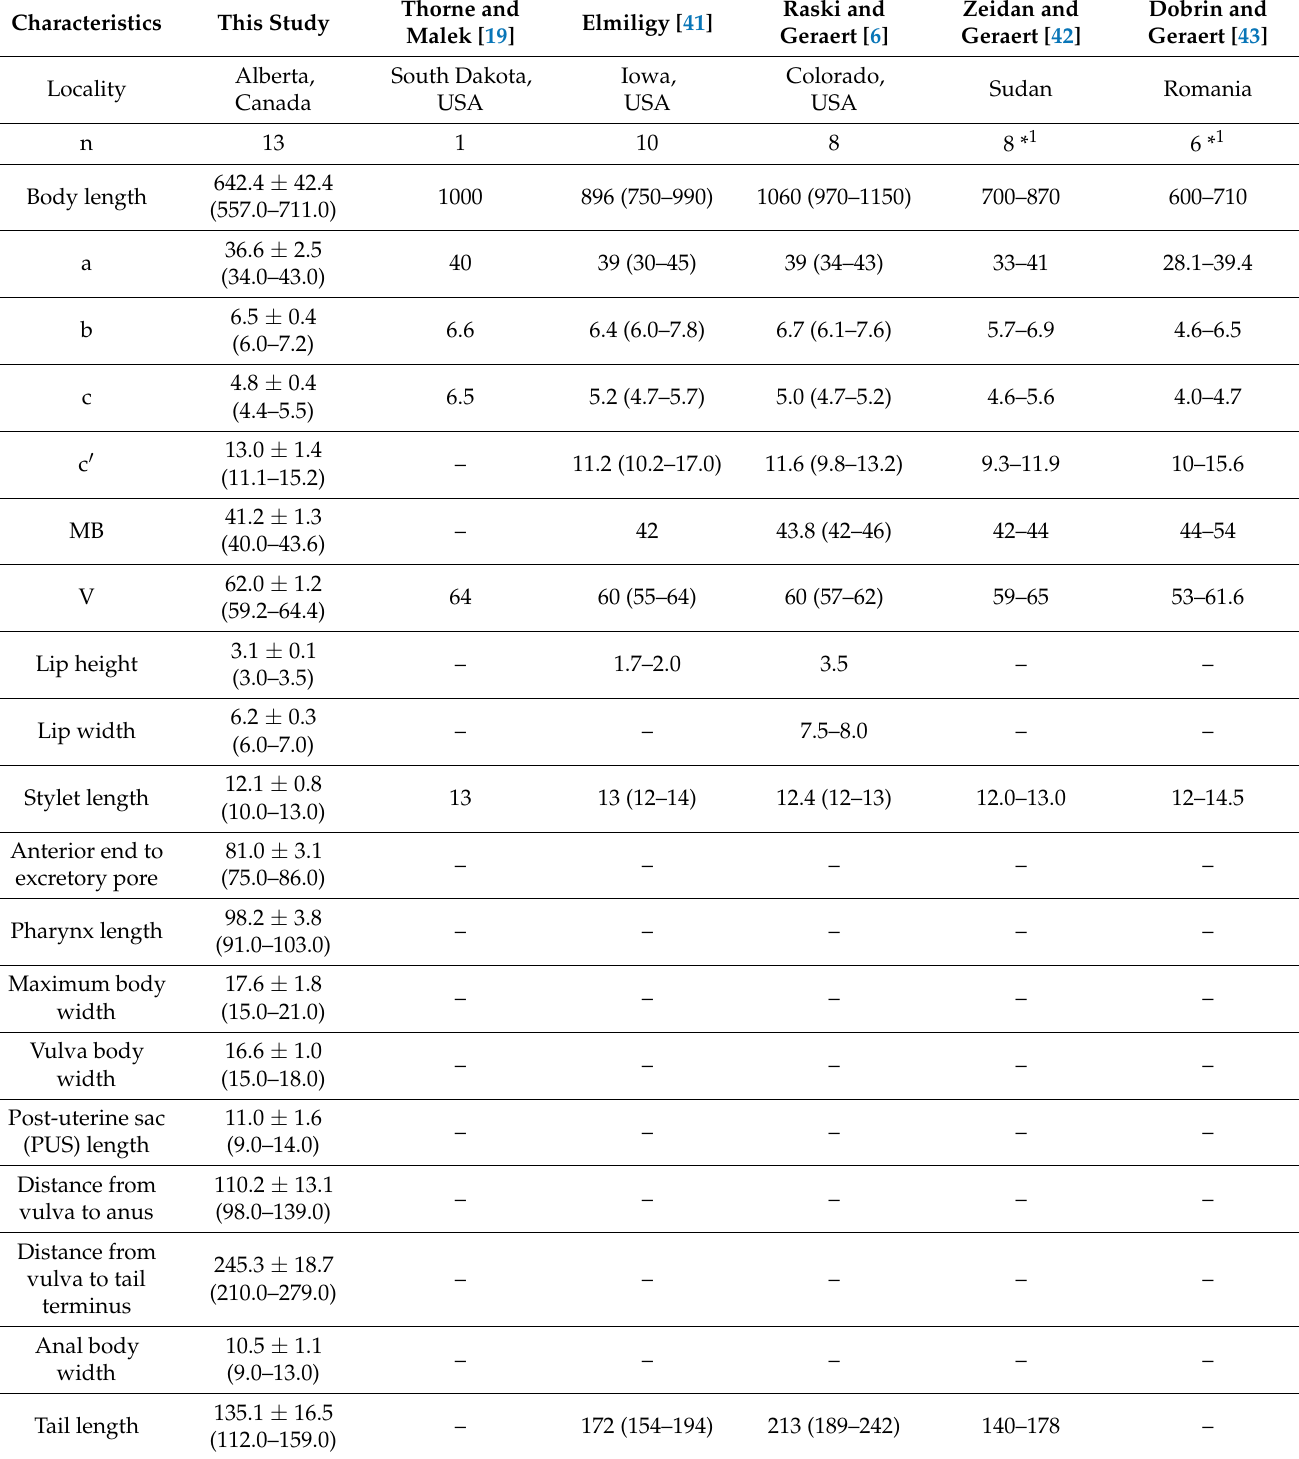
Table 1. Morphometrics of female Filenchus cylindricus (Thorne and Malek) Niblack and Bernard [18,19] examined in this study and from the original and subsequently published descrip- tions. All measurements are in µ m and in the form: mean ± standard deviation and/or